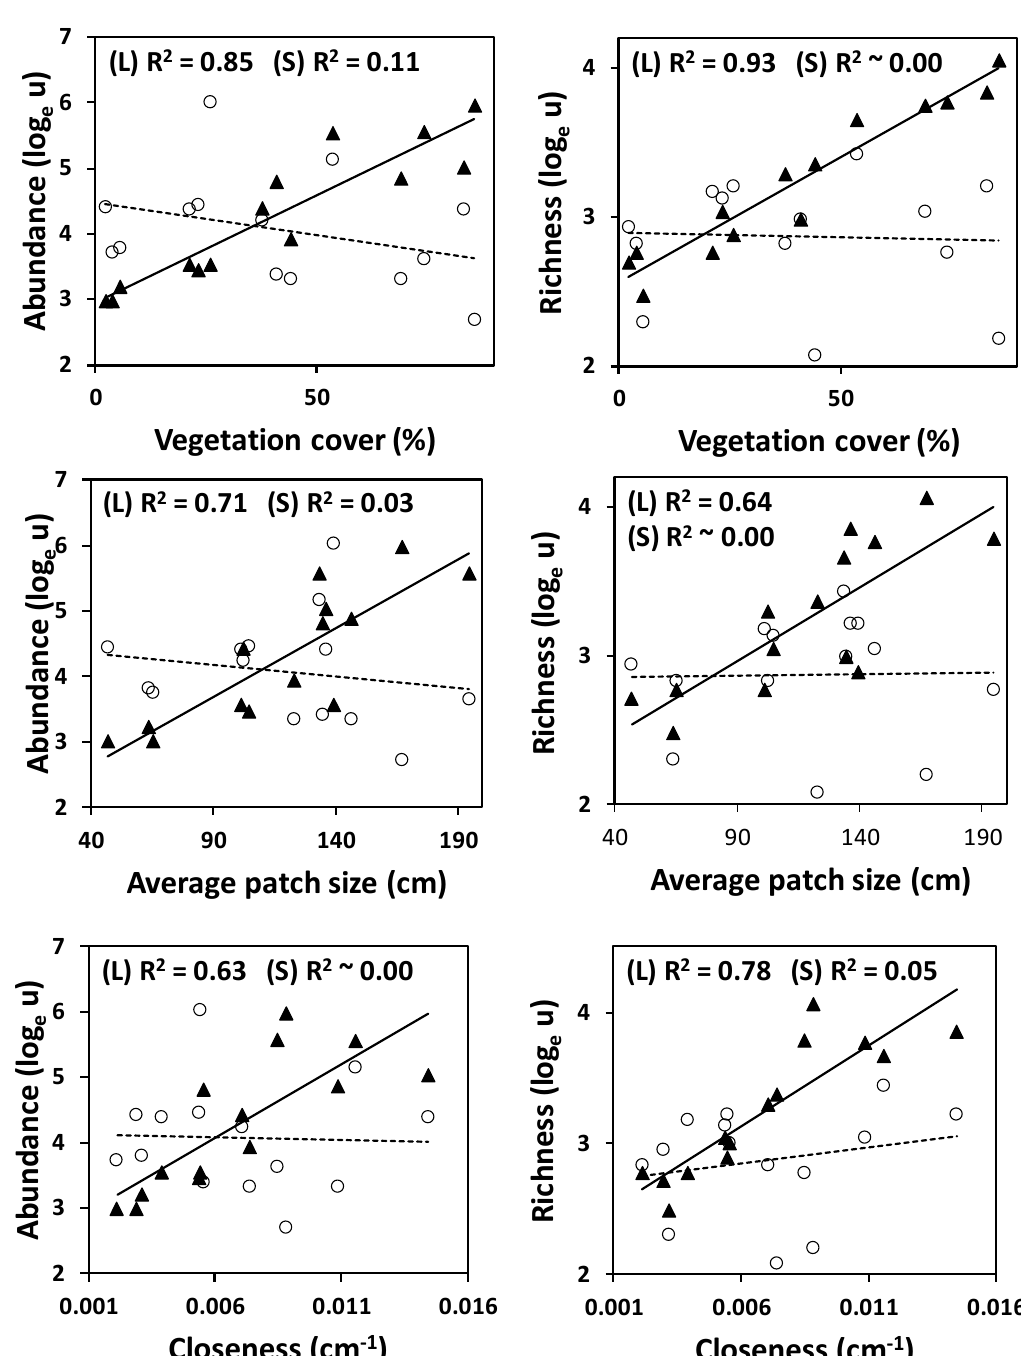
Figure 2. Relationships between log-scaled ground arthropod abundance (left panels) and richness (right panels) and landscape vegetation pattern metrics (vegetation cover, average patch size, and patch closeness) as a function of the soil layer: Litter (L) and soil (S). Continuous lines represent statistically significant linear regressions ( p ≤ 0.05) and dashed lines represent not significant regressions between the respective log-transformed response variable and the explanatory variable for each soil layer.